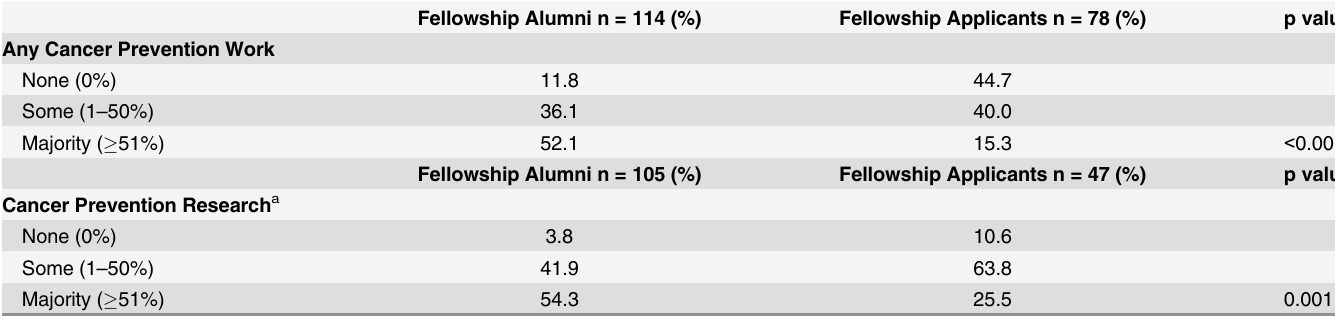
Table 2. Time Spent Performing Cancer Prevention-Related Work or Cancer Prevention